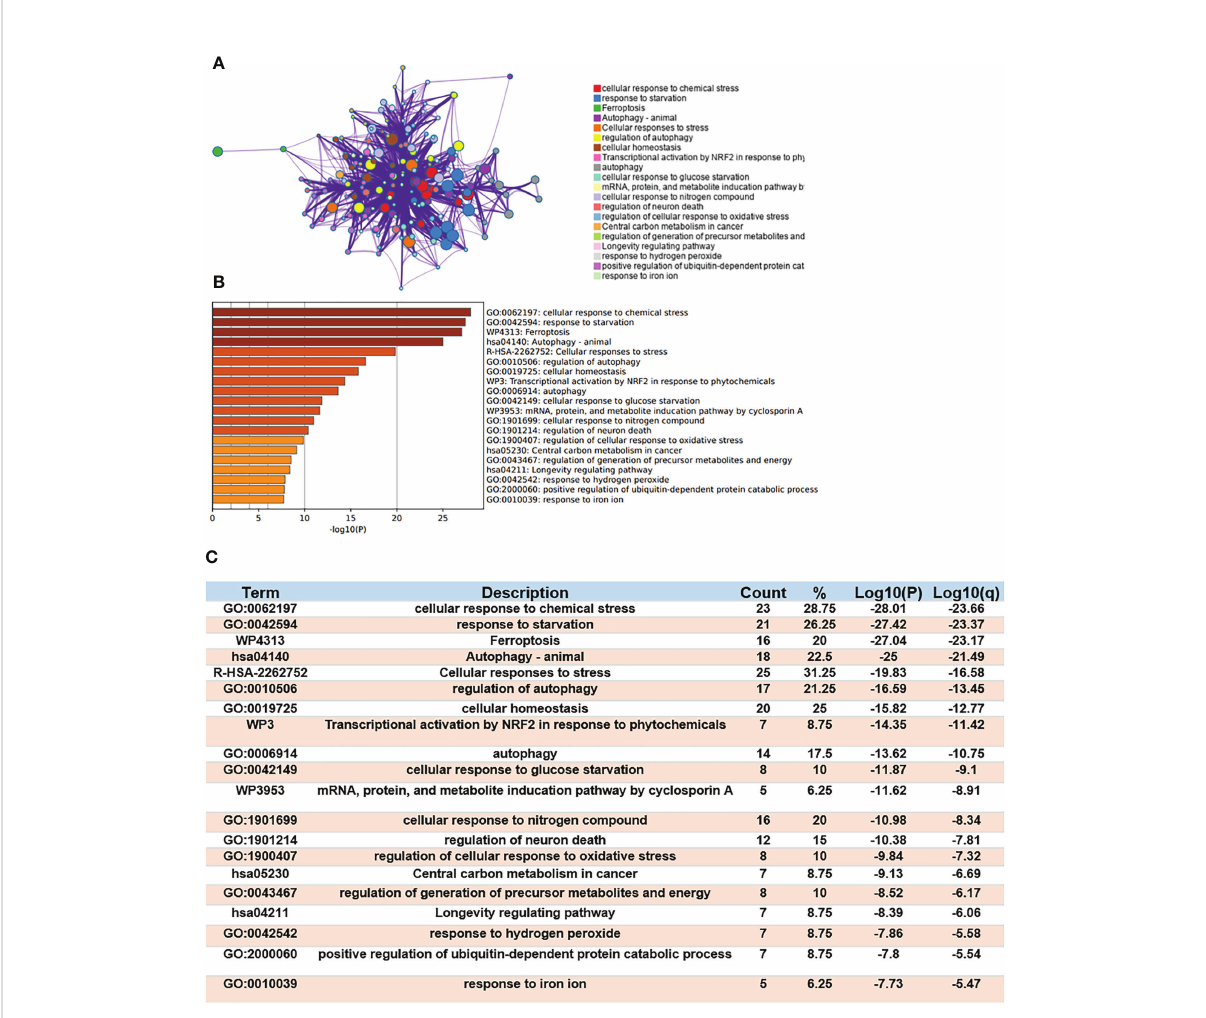
FIGURE 3 Functional enrichment analysis of DEGs. (A) Network of enriched terms. (B) A bar chart of top 20 biological pathways based on the P-value and the percentage of genes. (C) Details of top 20 biological pathways were listed in table.